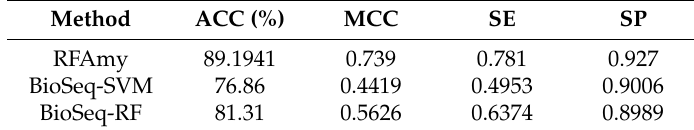
Table 4. The result of using different methods.